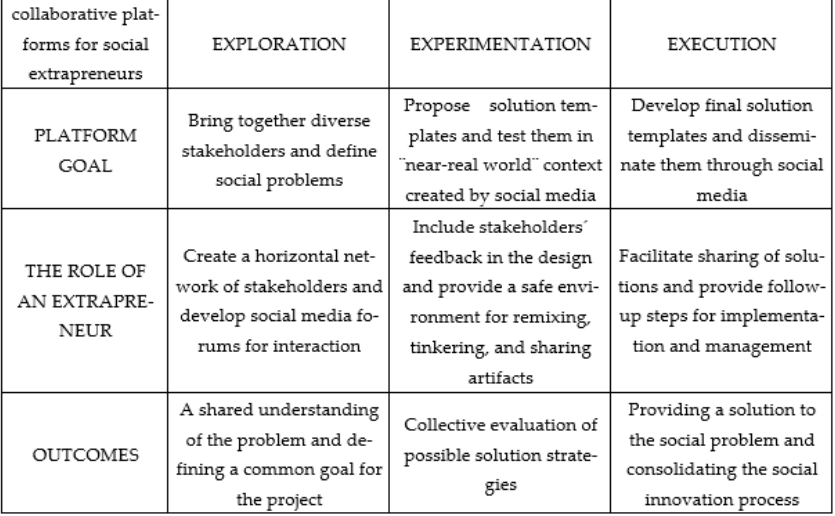
Figure 1. Three types of collaboration platforms for social innovation, based on Nambisan [50] (p. 47).